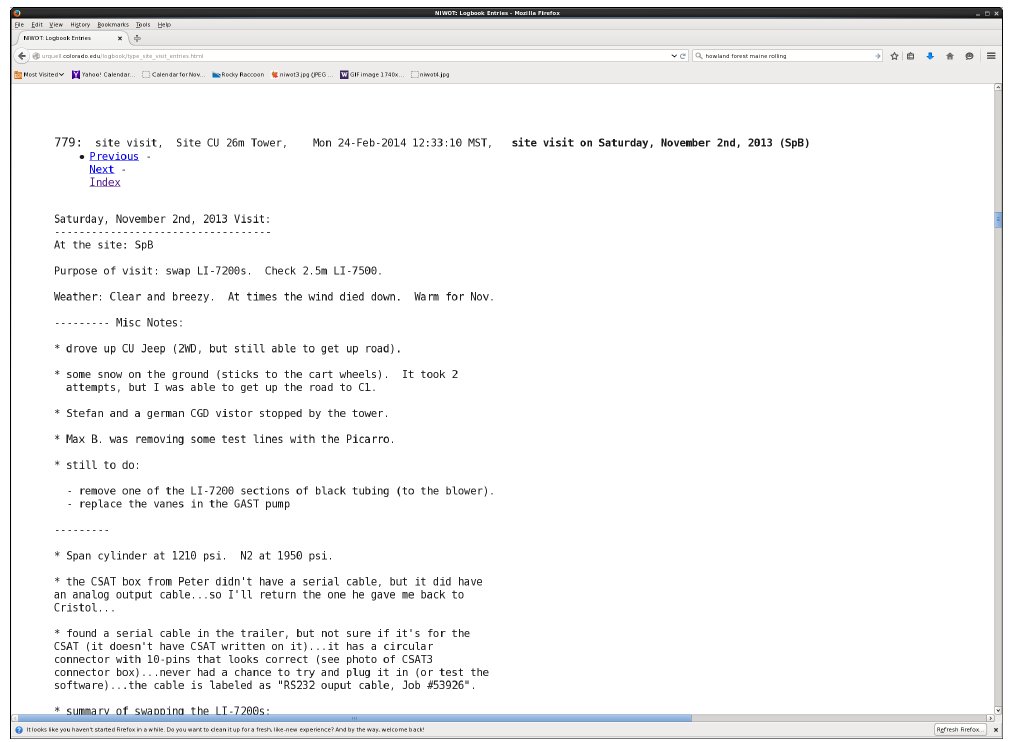
Figure 5. A screenshot example of the US-NR1 logbook entry from 2 November 2013. The logbook is accessible online at http://urquell.